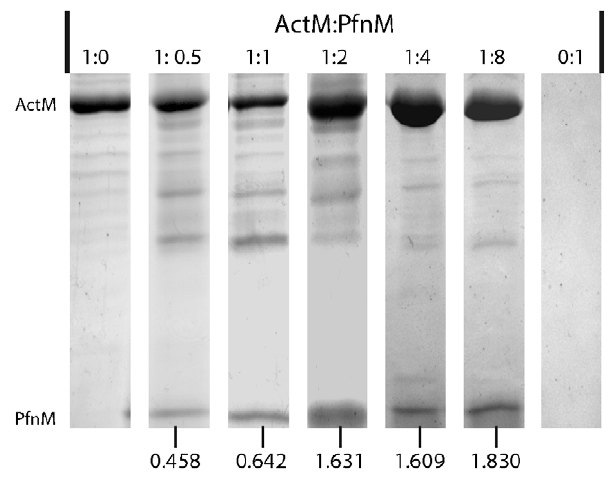
Figure 7. Polymerization and ultracentrifugation of ActM and PfnM. SDS-PAGE of pellet fractions of 7 reactions containing ActM and PfnM in different ratios (indicated at the top) after ultracentrifugation at 100,000 6 g. PfnM (17kDa) co-sediments with polymerized ActM (40 kDa), the relative amount of PfnM in the pellet is indicated at the bottom.